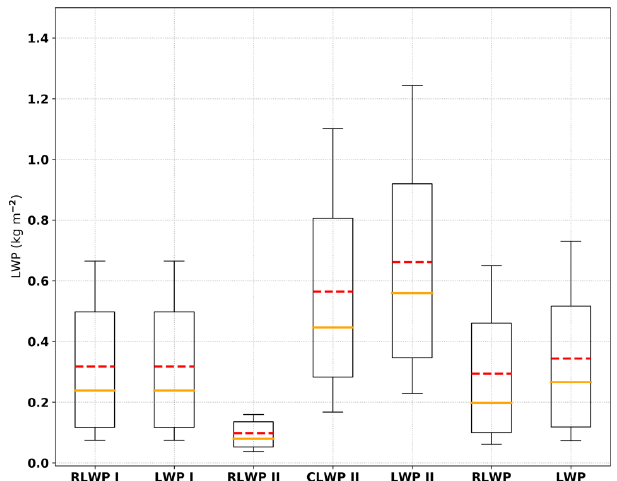
Figure 6. Box and whisker plots of retrieved RLWP, CLWP, and LWP for situation (I), (II), and all samples. The horizontal orange line within the box indicates the median, boundaries of the box rep- resent the 25th and 75th percentile, and the whiskers indicate the 10th and 90th percentile values of the results. The dashed red lines represent the mean